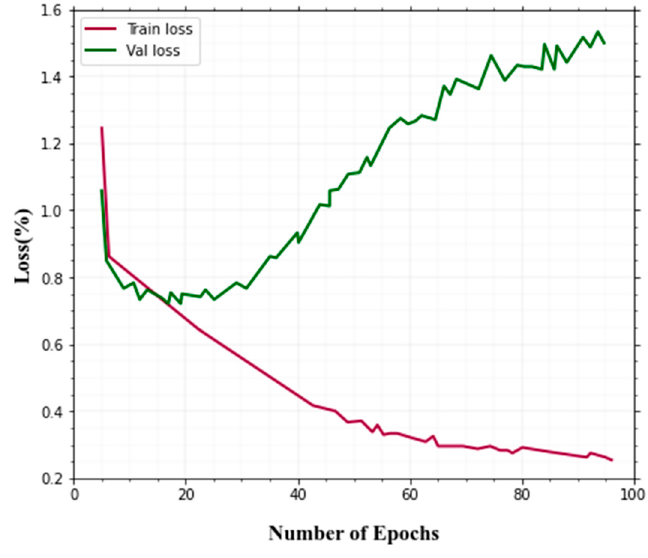
Figure 8. Training and validation loss.